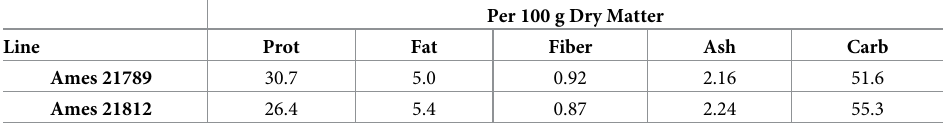
Table 1. Seed quality values for teosinte lines evaluated in 2014 at the South Dakota Research Farm, Aurora, South Dakota.